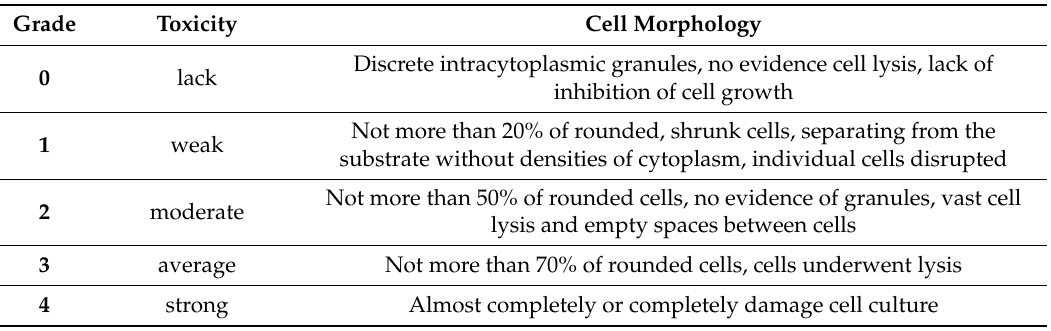
Table 8. Criteria of toxicity e ff ect based on changes in cell morphology (according to: EN ISO 10993-5:2009. Biological evaluation. Part 5: Test for in vitro cytotoxicity. International Organization for Standardization, Geneva, Switzerland,